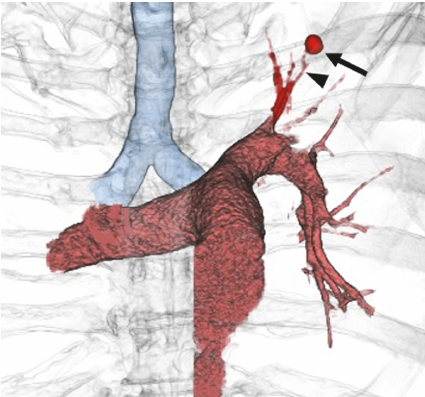
Figure 2: Volume rendering reconstructed image of the computed tomography angiography. The aneurysm (arrow) seems to originate from a branch of the left superior segmental pulmonary artery